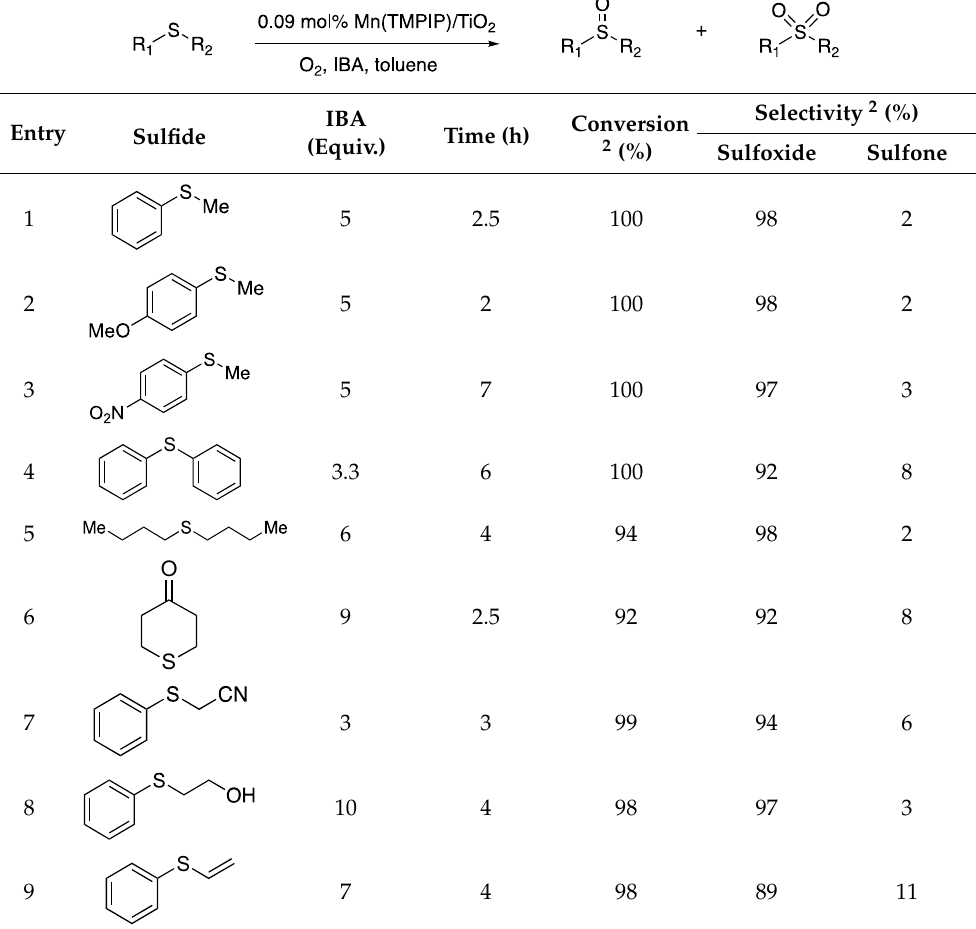
Table 2. Oxidation of sulfides by molecular oxygen in the presence of Mn(TMPIP)/TiO 2 and IBA 1 .